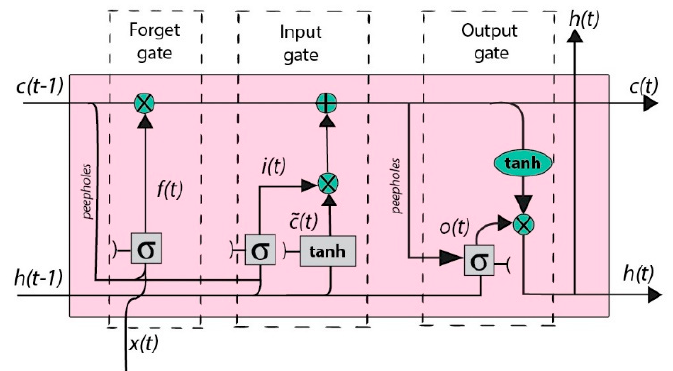
Figure 7. LSTM Architecture.